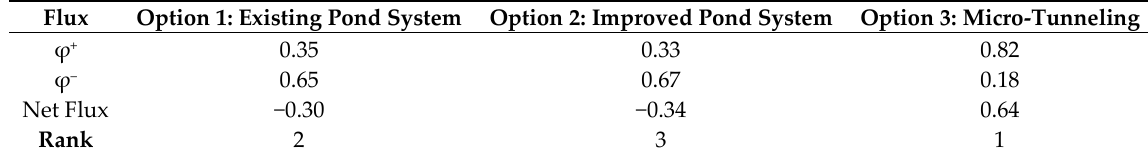
Table 8. Outranking relations using PROMETHEE II